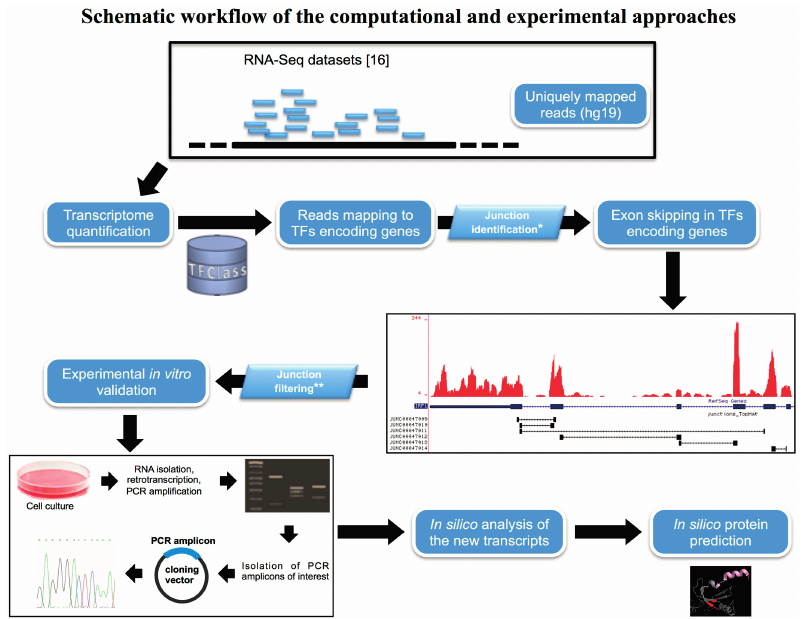
Figure 1. Computational and experimental workflow. Schematic overview of the in silico procedures used to infer the presence of new transcription factors (TFs) transcripts from the re-analysis of our RNA-Seq datasets. The experimental approach used to validate the presence of the new variants is also